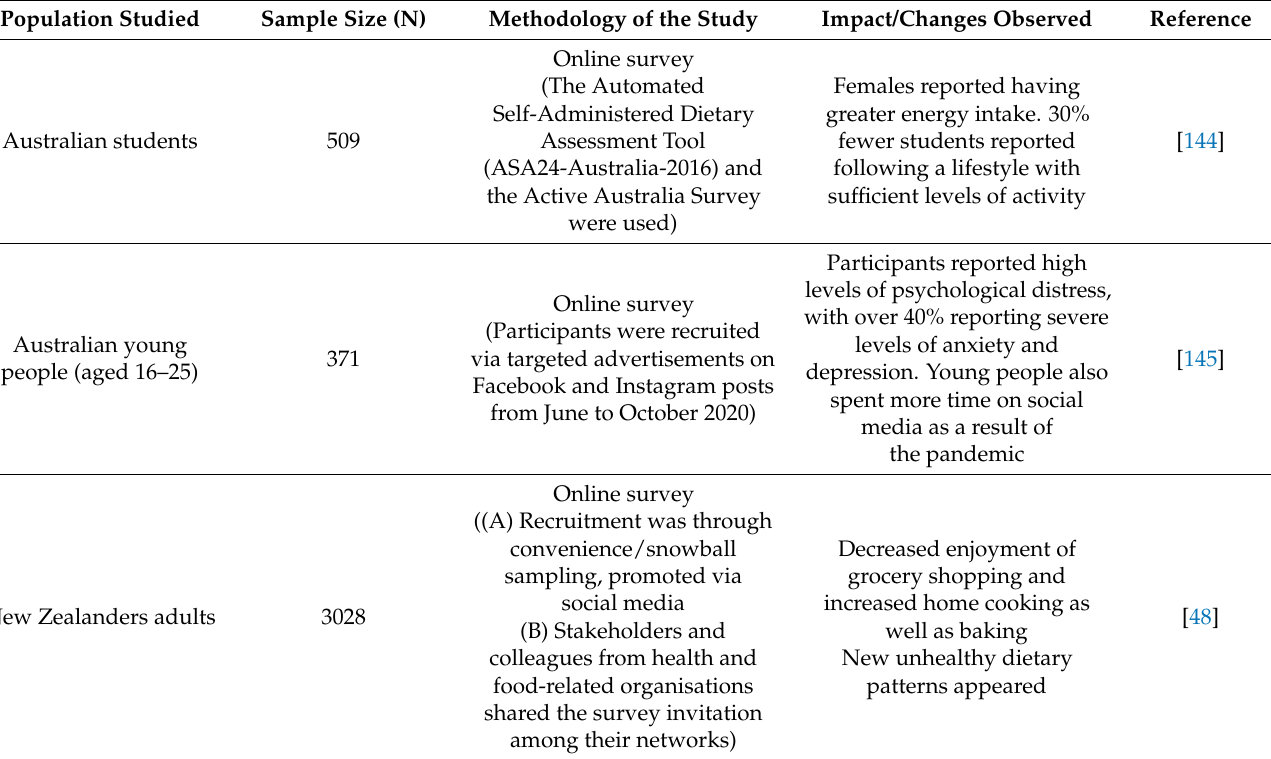
Table 6. Brief summary of studies related to the consequences of the lockdown in Oceanian populations.